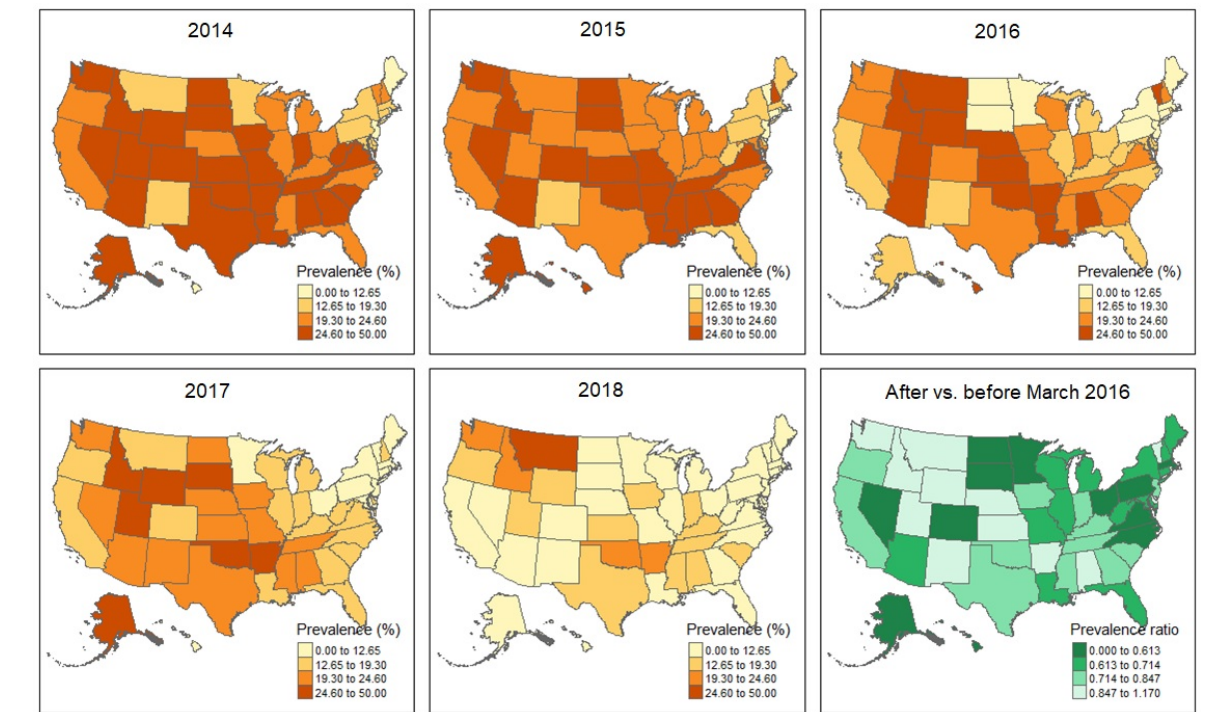
Figure 1. Between-state variations in prevalence of prescription opioid use in MVC injuries, US, 2014–2018. Abbreviation: MVC, motor vehicle crash.